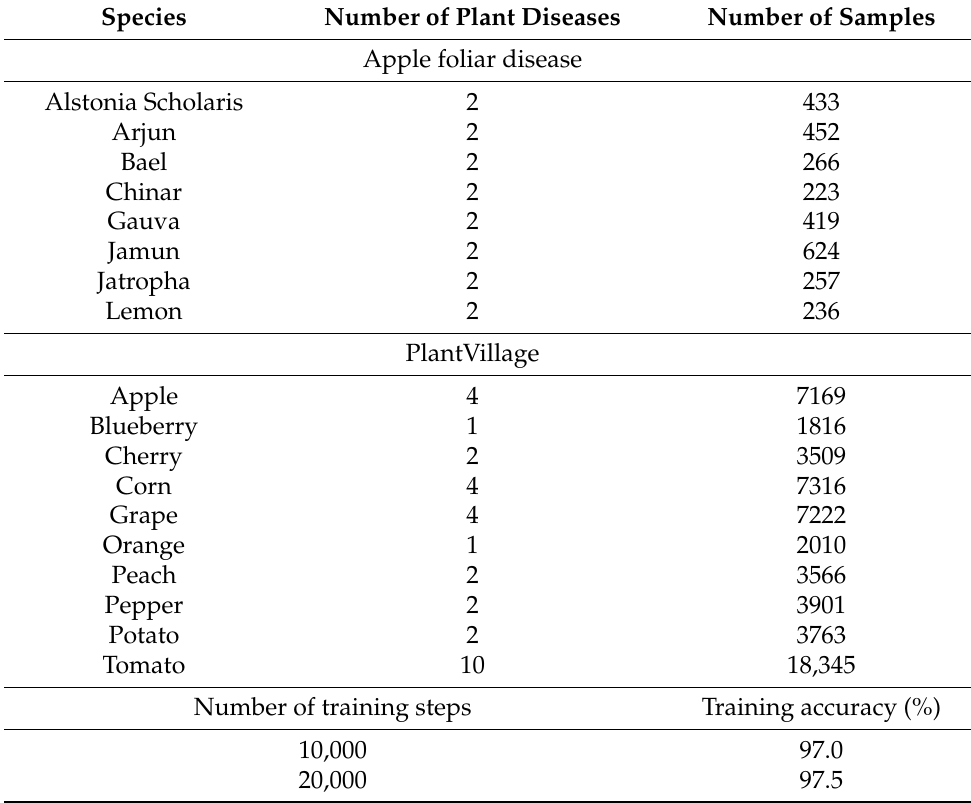
Table 3. LFM-CNAPS train results on in-domain